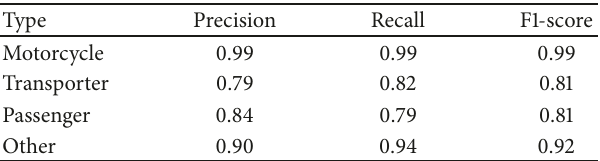
Figure 7: Examples of wrongly recognized vehicles images. First row: wrongly recognized as passenger which should be transporter.